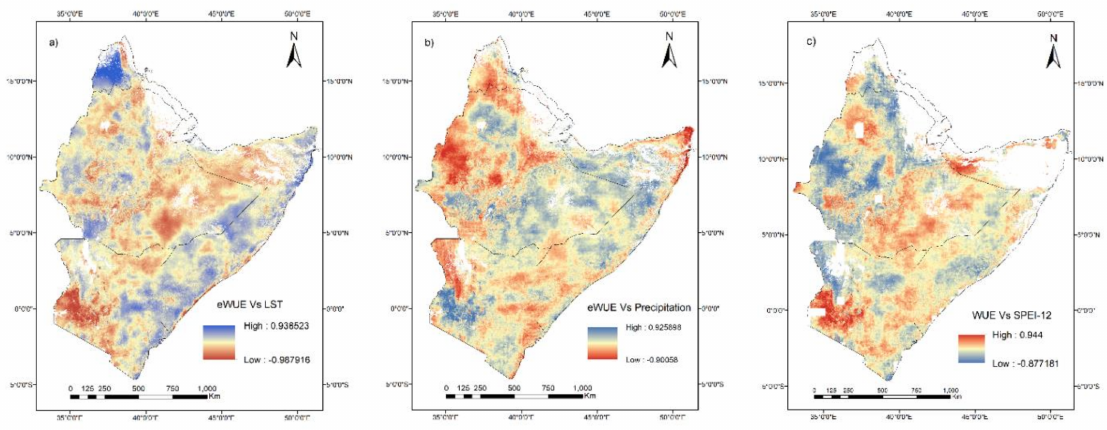
Figure 9. The correlation coefficient of annual eWUE versus mean annual land surface temperature ( a ), total annual precipitation ( b ), and SPEI-12 during 2000–2014 in the Horn of Africa ( c